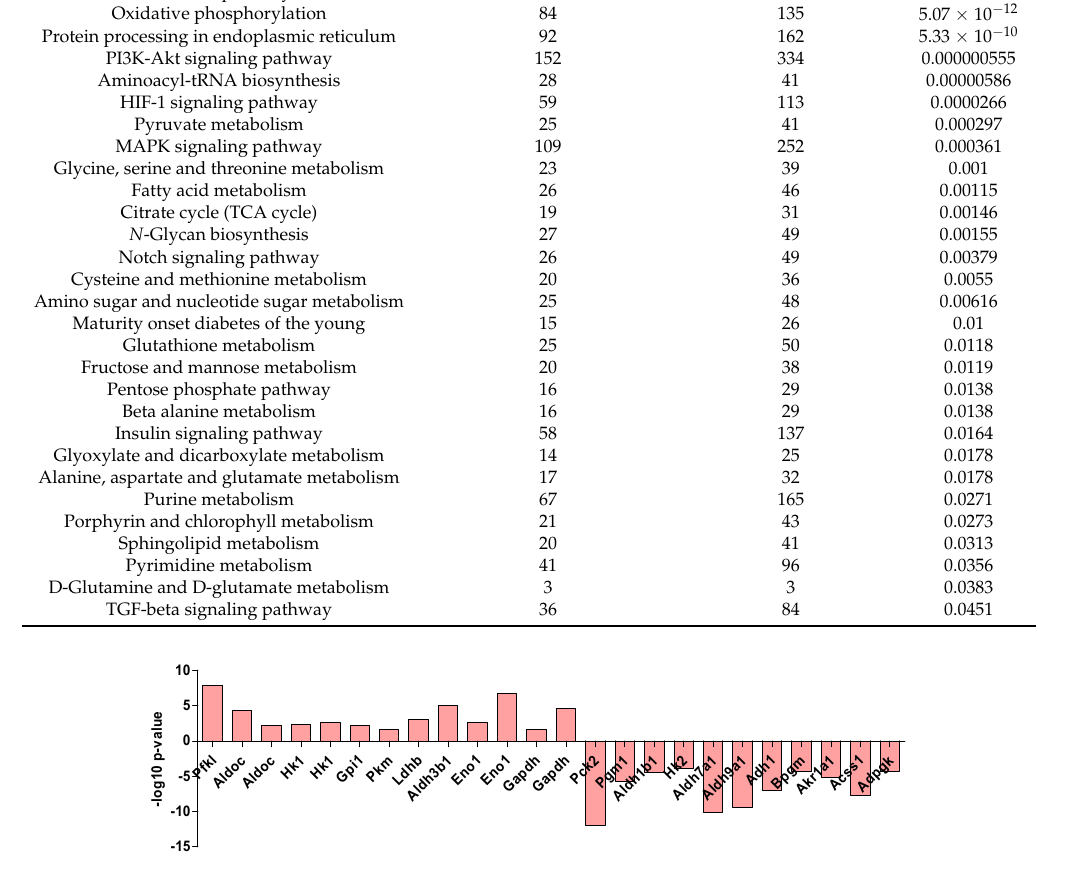
Figure A1. Significantly changed genes enriched in different KEGG pathways (represented by p -values) in progenitor-like cells cultured in vitro, compared to pancreatic single cells. Each column represents the mRNA level of the glycolysis-related enzymes. As shown, a portion of the glycolysis-related enzymes are up-regulated in progenitor-like cells.